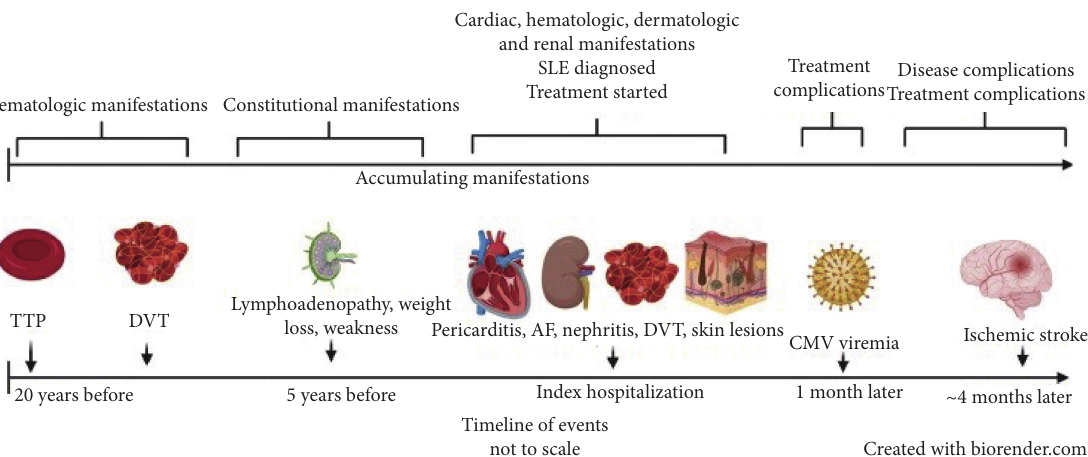
Figure 2: Timeline of events in the patient’s course over 20 years. AF: atrial fibrillation; CMV: cytomegalovirus; DVT: deep vein thrombosis, TTP: thrombotic thrombocytopenic